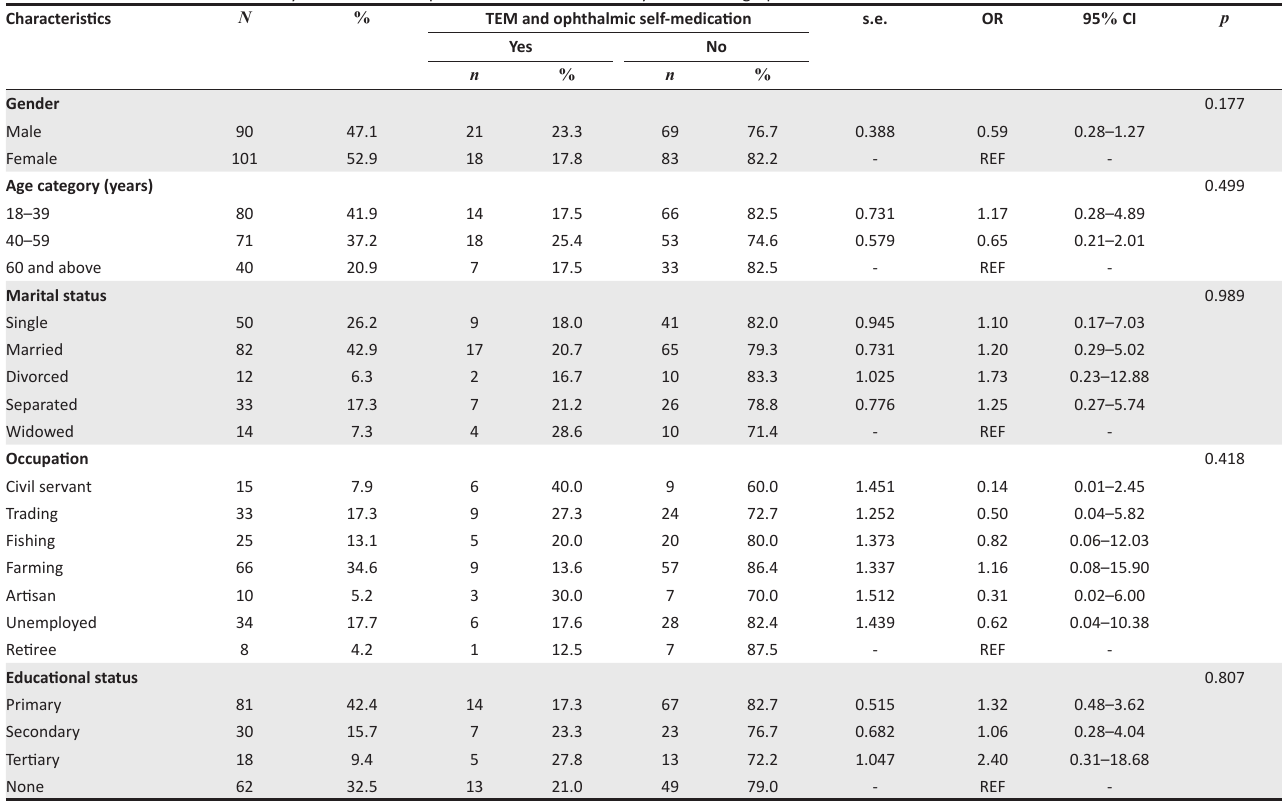
TABLE 4: Combination of traditional eye medicine and ophthalmic self-medication by socio-demographic characteristics.